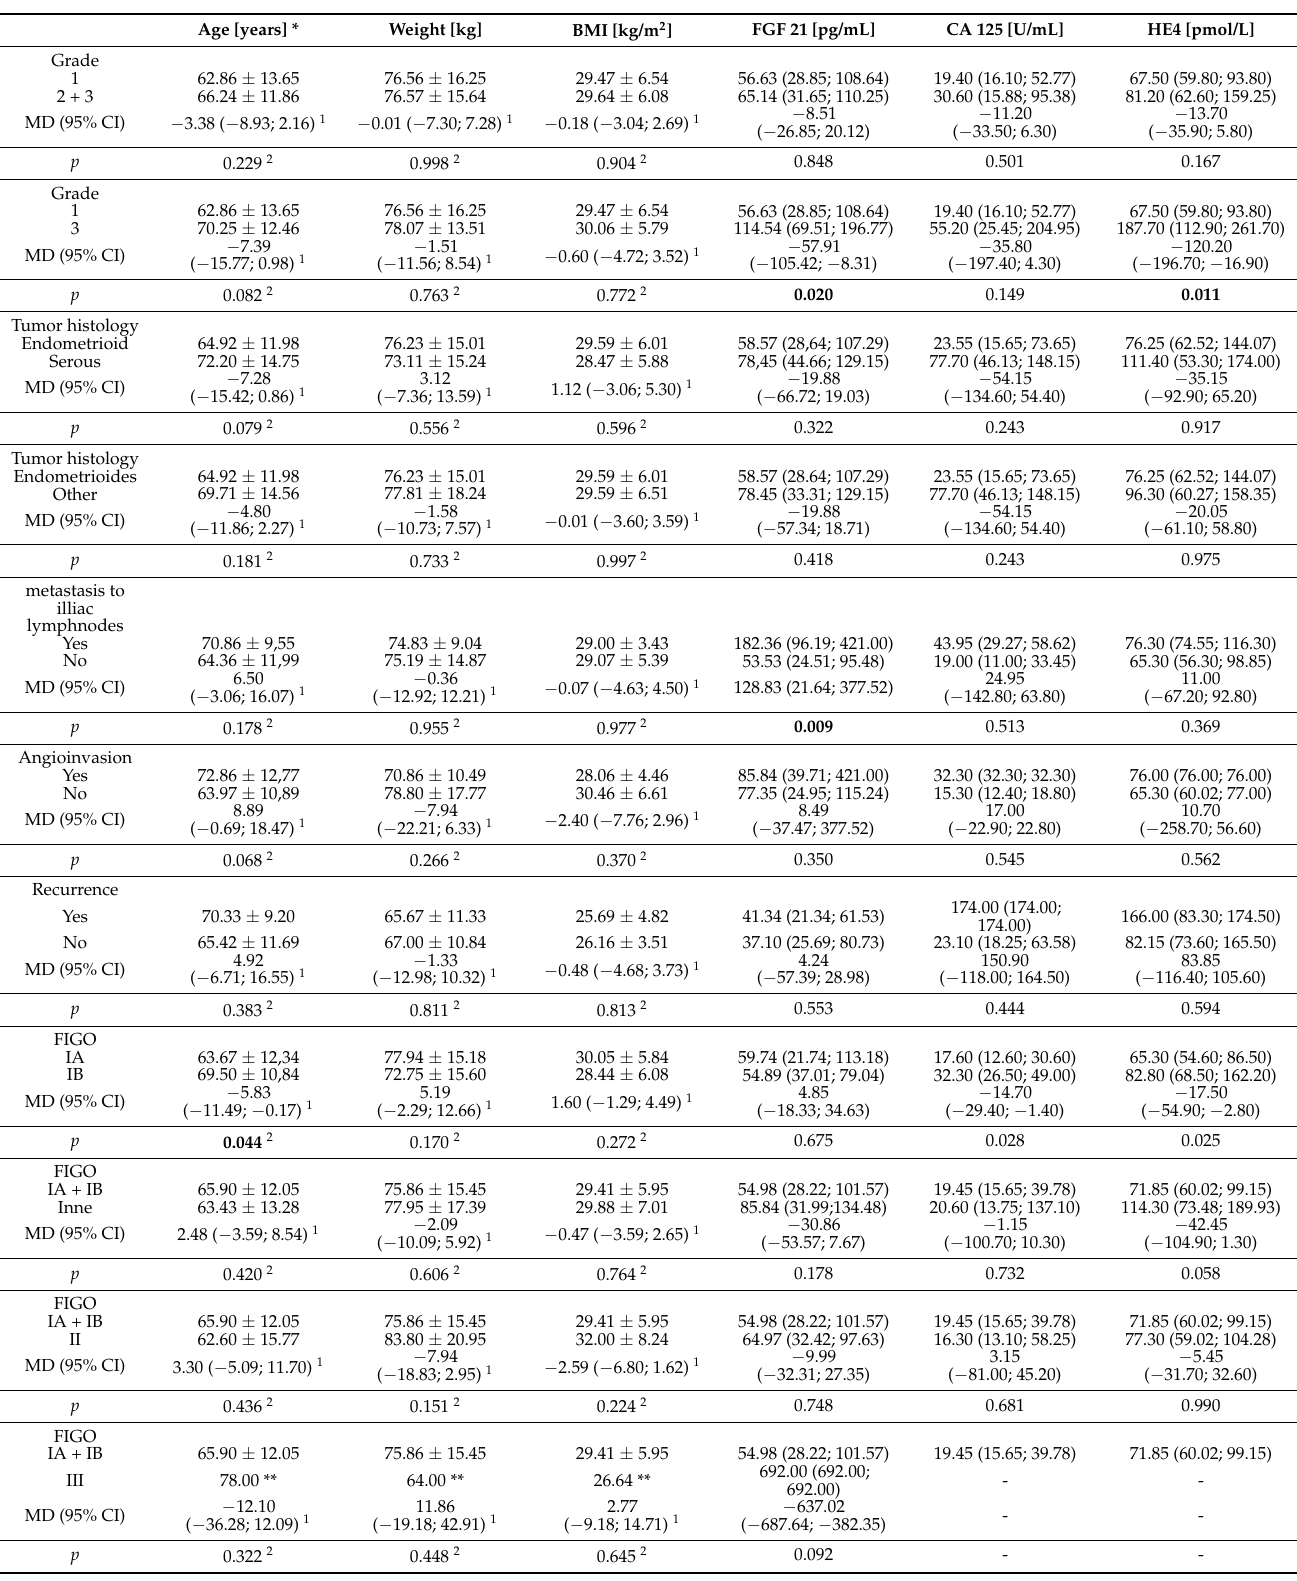
Table 6. Comparison of the selected variables among endometrial cancer